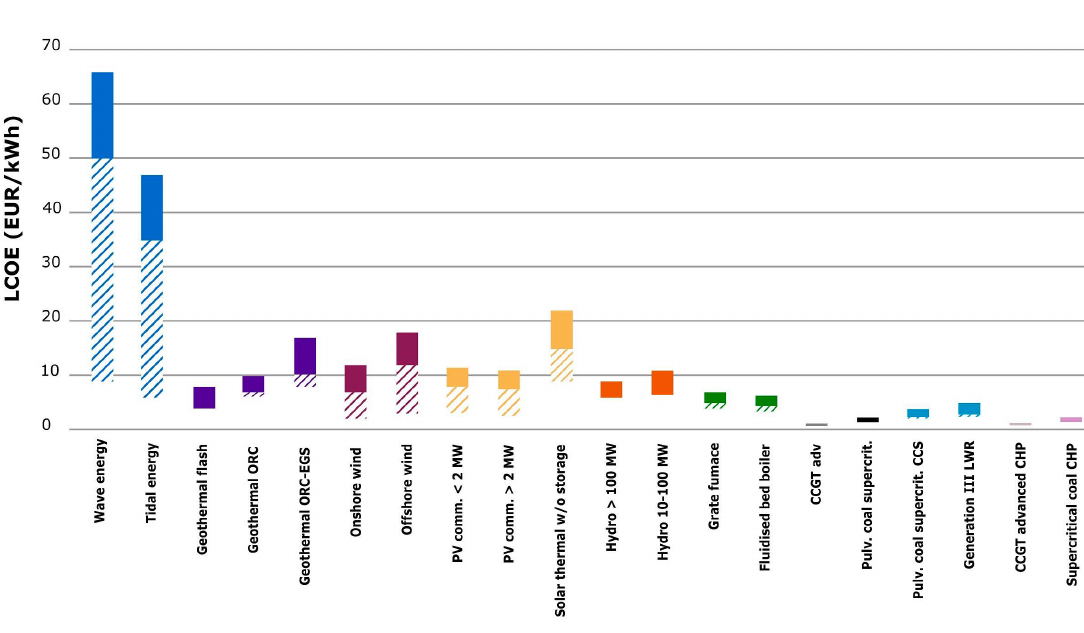
Figure 15. LCOE for different energy technologies [9]. The solid bars indicate the actual LCOE span and the striped ones, the future cost reductions expected. c (cid:13) Reproduced with permission from Elsevier,